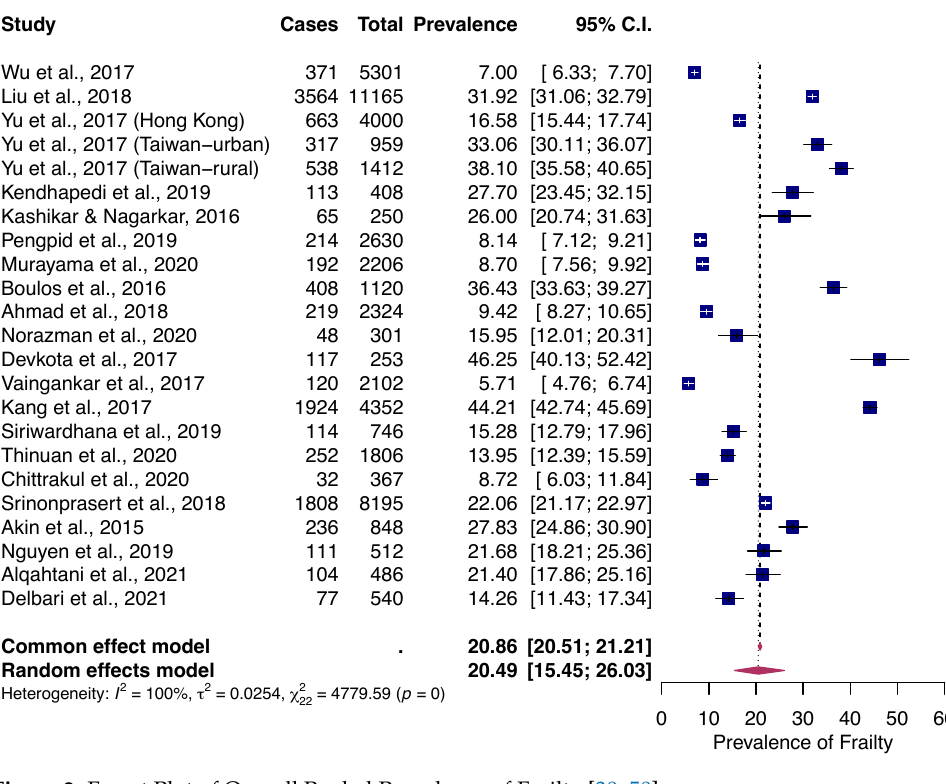
Figure 2. Forest Plot of Overall Pooled Prevalence of Frailty [30–50].